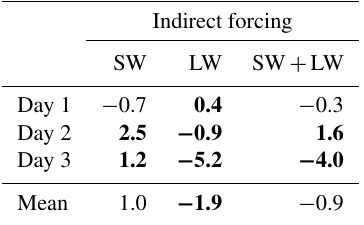
Table 4. Indirect forcing of absorbing aerosol, computed as the diurnal-average difference in radiative fluxes at TOA (in Wm − 2 ) of the simulation with absorbing aerosol not directly affecting ra- diation, relative to the lightly drizzling baseline case ( N a , sulfate = 150mg − 1 ). Conventions as in Table